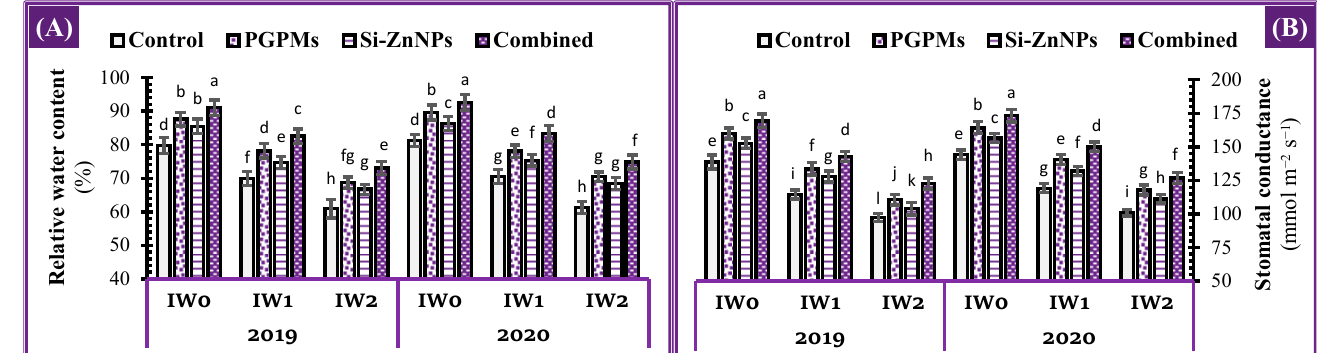
Figure 7. Influence of application of PGPMs, Si-ZnNPs and their combination on water relations, i.e., ( A ) leaf relative water content, and ( B ) stomatal conductance in the leaves of soybean plant grown in salt-affected soil with different levels of watering intervals ( IW 0 ; 11 days, IW 1 ; 15 days, and IW 2 ; 19 days) during the successive 2019 and 2020 growing seasons. The data presented as means ± SD. Means labeled with the same lower-case letter are not significantly different according to Duncan’s Multiple Range Test.